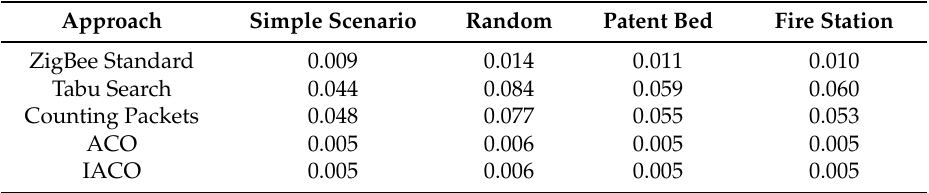
Table 21. MAC Delay Comparison.